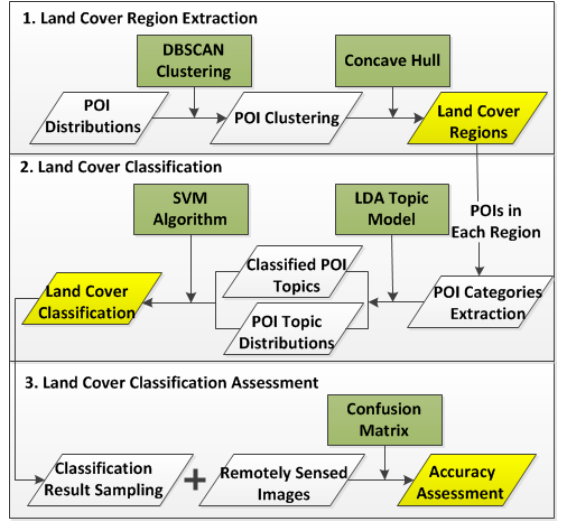
Figure 3. The overview of the research framework.